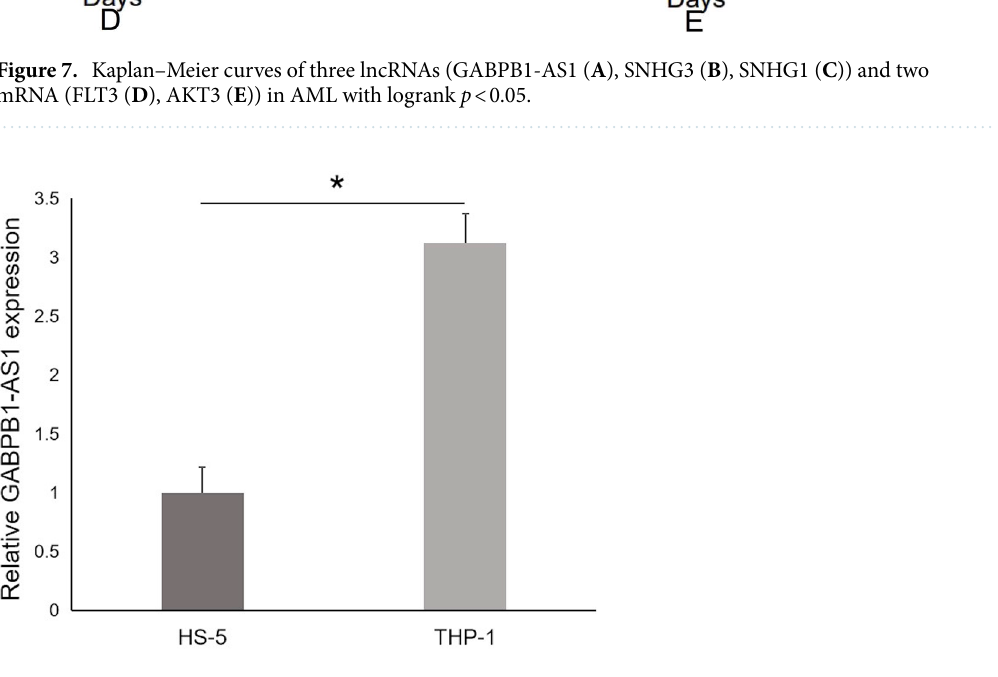
Figure 8. Comparing differences in the expression levels of GABPB1-AS1 between THP-1 cells and normal HS-5 cells. * p <